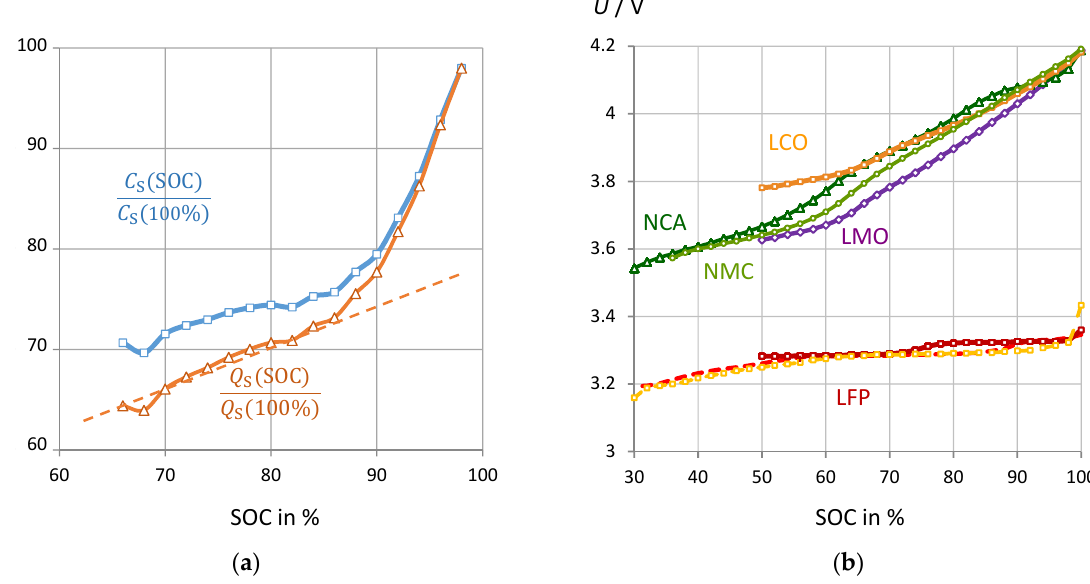
Figure 9. ( a ) NMC battery #8: Normalized pseudocapacitance and pseudocharge at 0.1 Hz (reference: 589 F and 2470 As at SOC = 100%) versus “true” SOC from Ah counting. ( b ) Cell voltage of different cell chemistries versus state-of-charge from Ah counting. Batteries under test see Table 1.